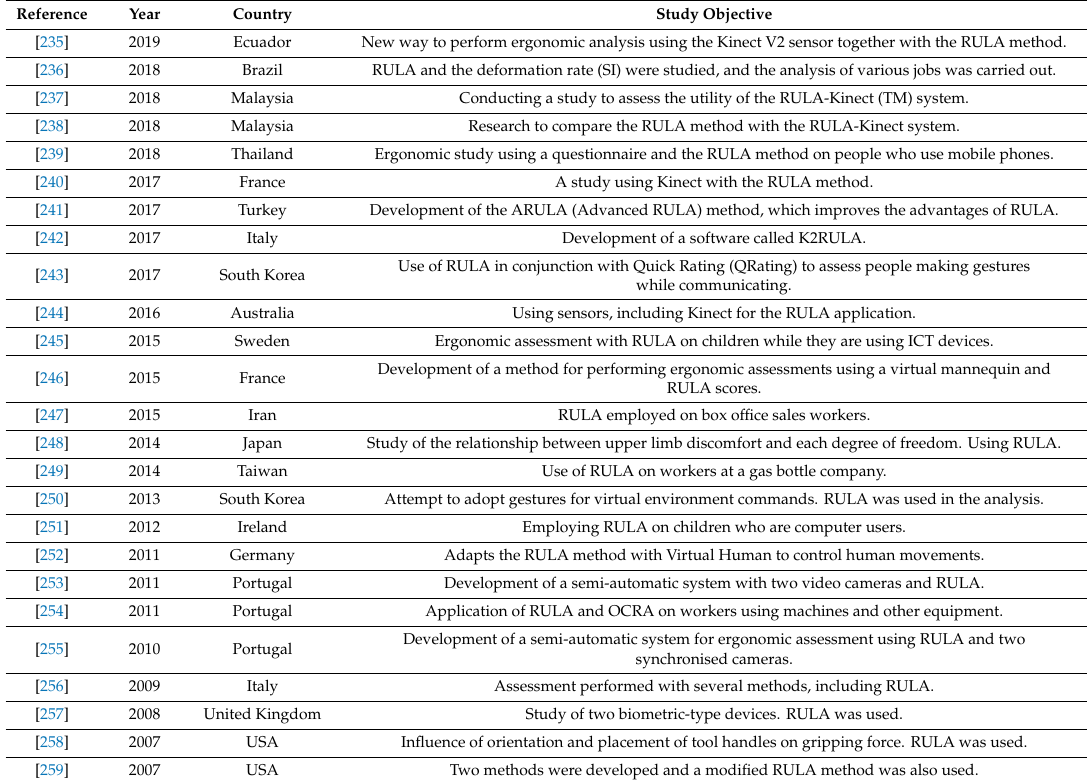
Table 21. Other scopes not previously